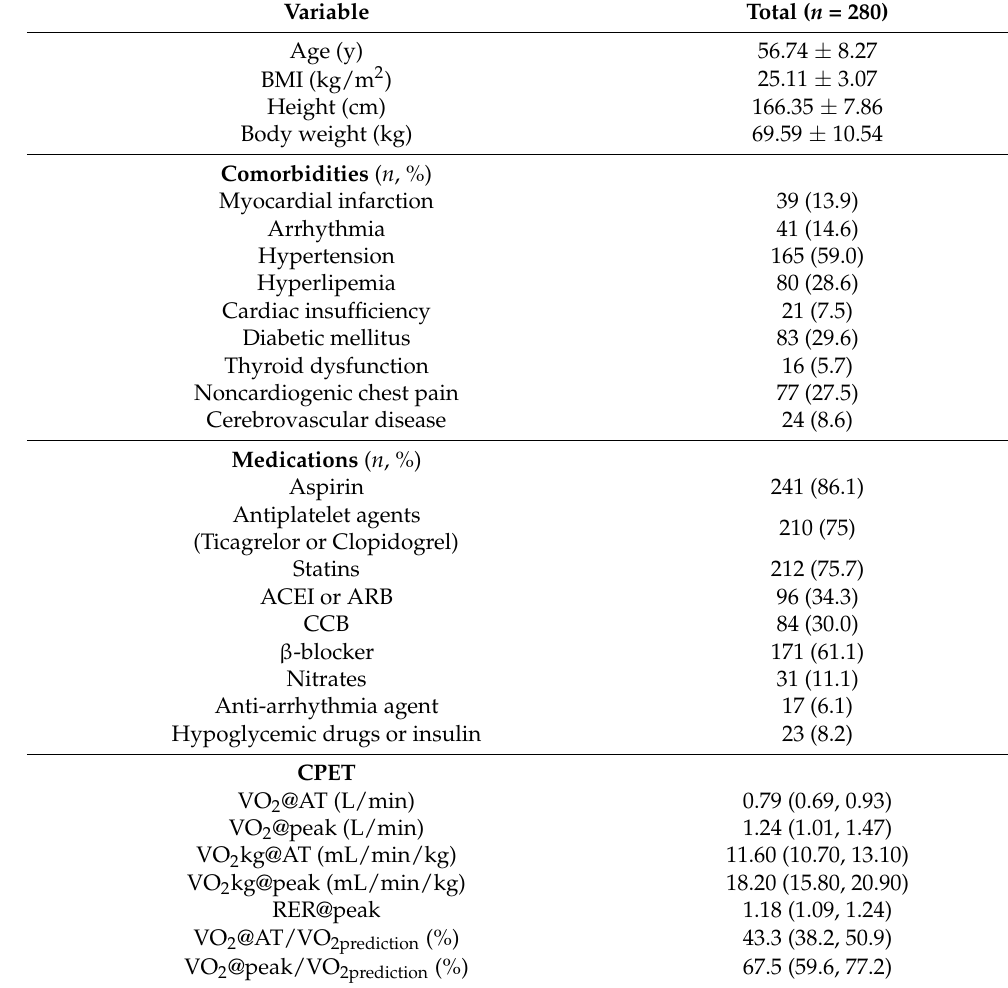
Table 1. Baseline characteristics of study